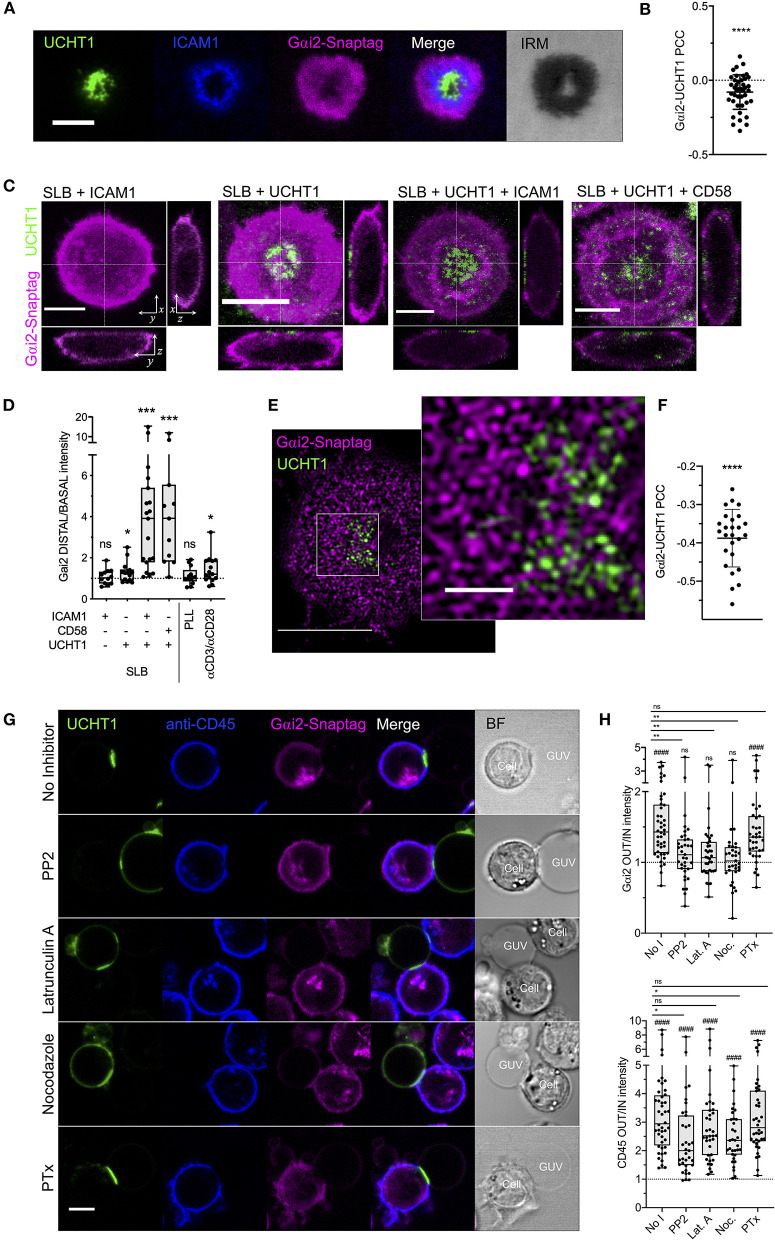
Gαi2 distribution within the synapse. (A) TIRFM example of Gαi2-SNAP-tag in a CD4+ T cell blast on activating SLB for 10 min. (B) PCC values for Gαi2 vs. UCHT1 in TIRF-imaged cells. Each point represents a single cell. Significance is shown relative to a value of 0 assessed with a one sample, two-tailed t-test. (C) Max-intensity projections and orthogonal views of confocal microscopy z-stacks of CD4+ T cell blasts on SLB presenting ICAM1, UCHT1, ICAM1 + UCHT1, or CD58 + UCHT1. (D) Ratio of Gαi2-SNAP-tag intensity at the distal vs. basal membranes for CD4+ T cell blasts on the indicated SLB compositions or glass surfaces coated with PLL or anti-CD3/CD28 antibodies. Box and whiskers show mean, maximum, minimum, upper, and lower quartiles. Significance is shown relative to a value of 1 assessed with a one-sample, two-tailed t-test. (E) TIRF-SIM example of Gαi2-SNAP-tag in a CD4+ T cell blast on activating SLB for 10 min. (F) PCC values for of Gαi2 vs. UCHT1 in TIRF-SIM-imaged cells. Significance is shown relative to a value of 0 assessed with a one sample, two-tailed t-test. (G) Confocal microscopy images at the equatorial plane of Gαi2-SNAP-tag-expressing, anti-CD45-stained CD4+ T cell blasts interacting with ICAM1 + UCHT1-bearing GUVs in the presence of indicated inhibitors. (H) Gαi2-SNAP-tag and CD45 intensities outside vs. inside cell-GUV contact regions. Significance vs. a fixed value of 1 as assessed by a one-sample two-tailed t-test is represented with hashes (####p < 0.0001). Significance between samples indicated by bars was assessed with a two-tailed t-test. *p < 0.05, **p < 0.01, ***p < 0.001, ****p < 0.0001, n.s., not significant. All scale bars are 5 μm except for zoomed inserts (1 μ m). All pooled data represent a minimum of n = 3 independent donors.